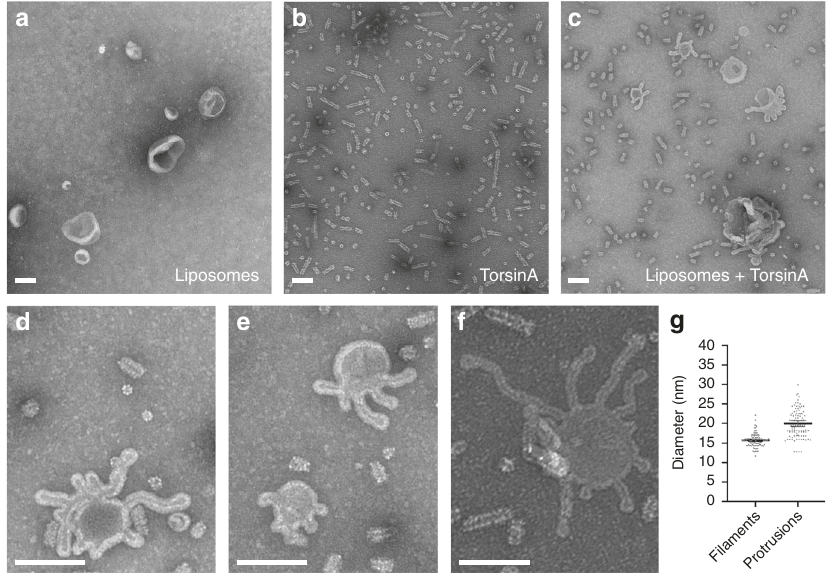
Fig. 3 TorsinA tubulates acidic membranes in vitro. a Negative-stain electron micrograph of moderately acidic liposomes. b Negative-stain electron micrograph of MBP-TorsinA incubated with 3C protease for 6 h at RT. c Negative-stain image of the moderately acidic liposomes which are tubulated after incubation with MBP-TorsinA and 3C protease for 6 h at RT. d , e , f Higher magni fi cation views of tubulated liposomes with protrusions of various diameter decorated with a coat of TorsinA. Scale bar is 100 nm in all micrographs. g Scatter plot of the diameters measured from negative-stain micrographs using ~100 fi laments and ~100 lipid protrusions. Mean values are shown together with 95% con fi dence